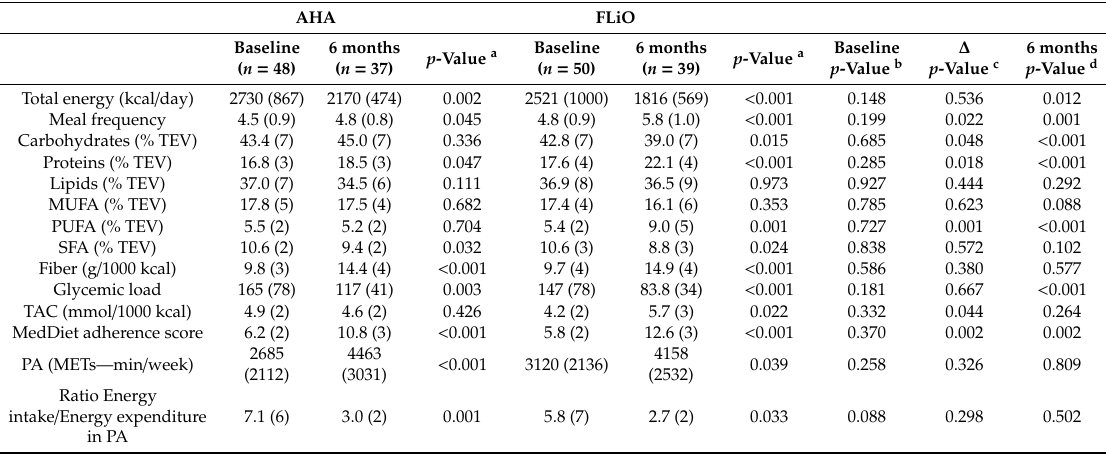
Table 3. Dietary intake and physical activity at baseline and after 6 months of dietary intervention in subjects with NAFLD according to the group of intervention. AHA FLiO Baseline Baseline 6 months p -Value p -Value a ( n = 50) ( n = 48) ( n = 37)